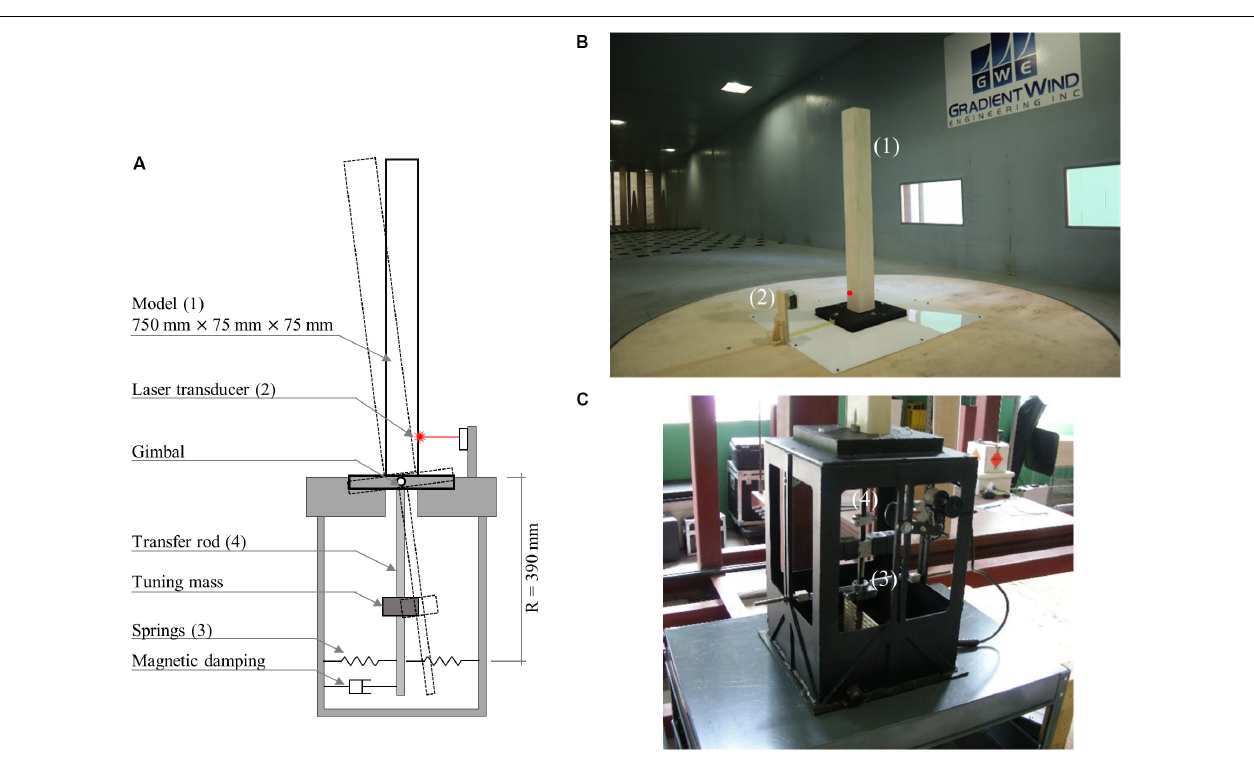
FIGURE 9 | Conventional aeroelastic test for buildings. (A) Schematic configuration, (B) base-pivoting model in wind tunnel, and (C) aeroelastic test rig (the lower part with spring, mass and damper).